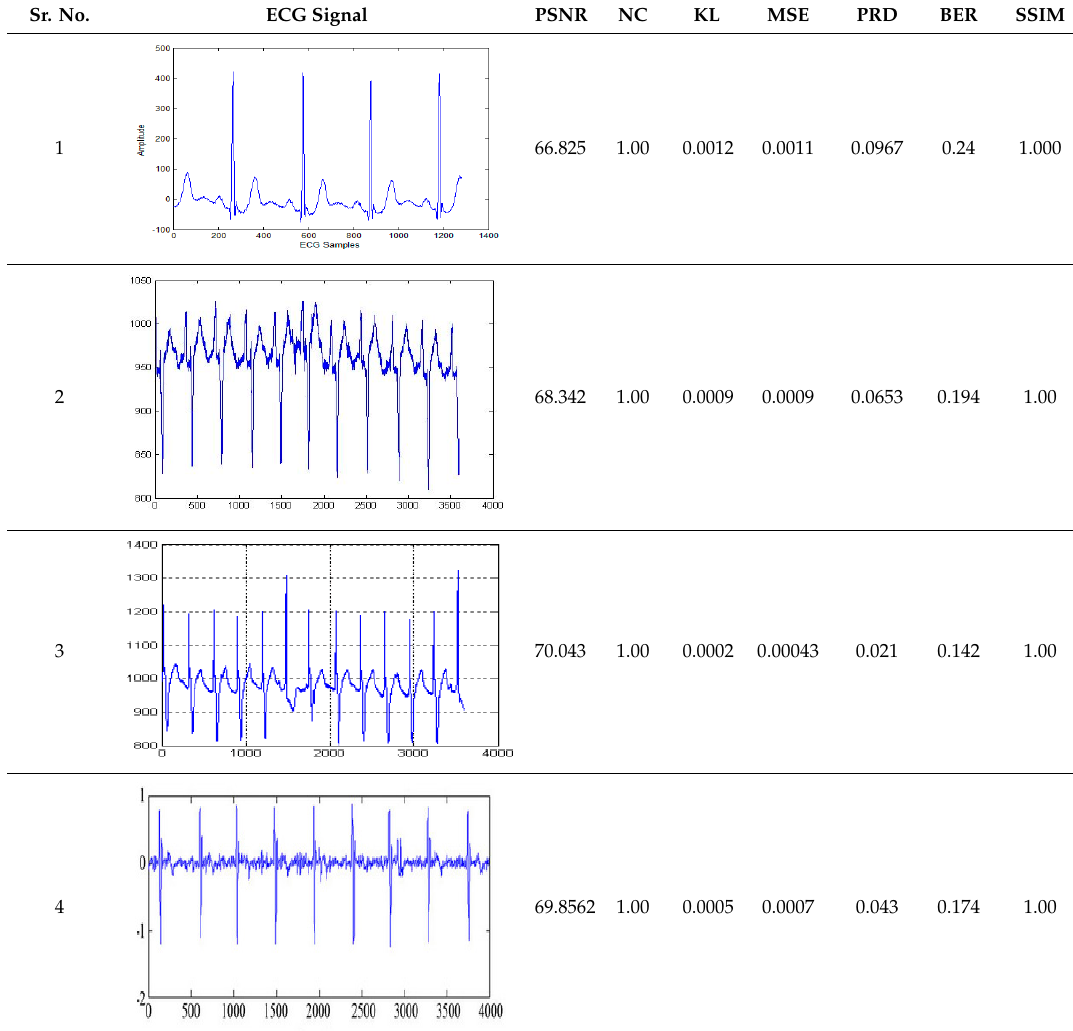
Table 2. Performance of proposed techniques with di ff erent watermark sizes and